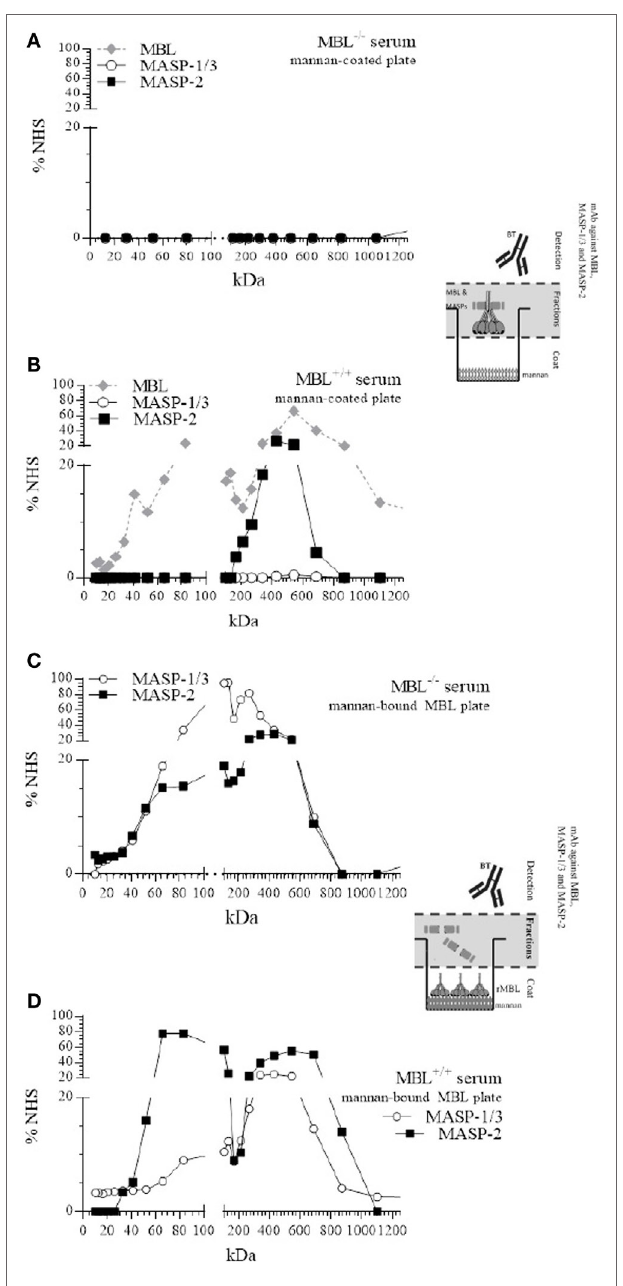
FigUre 2 | Size-exclusion chromatography (SEC) of mannan-binding lectin (MBL)-deficient and MBL-sufficient serum. SEC of MBL-deficient serum (a,c) or MBL-sufficient serum (B,D) . Serum was fractionated on a Superdex ™ 200 10/300 GL column (a,c) . Fractions were tested for the presence of MBL, or MBL–MBL-associated serine protease (MASP)-1/3, MBL–MASP-2 complexes on mannan-coated plates and compared with a pool of normal human sera (NHS). (B,D) Mannan-coated plates were pre-incubated with fixed amount of recombinant MBL, and followed by the different fractions of MBL-deficient or MBL-sufficient serum, and the formation of new MBL–MASP-1/3 or MBL– MASP-2 complexes was detected and compared with a pool of NHS.